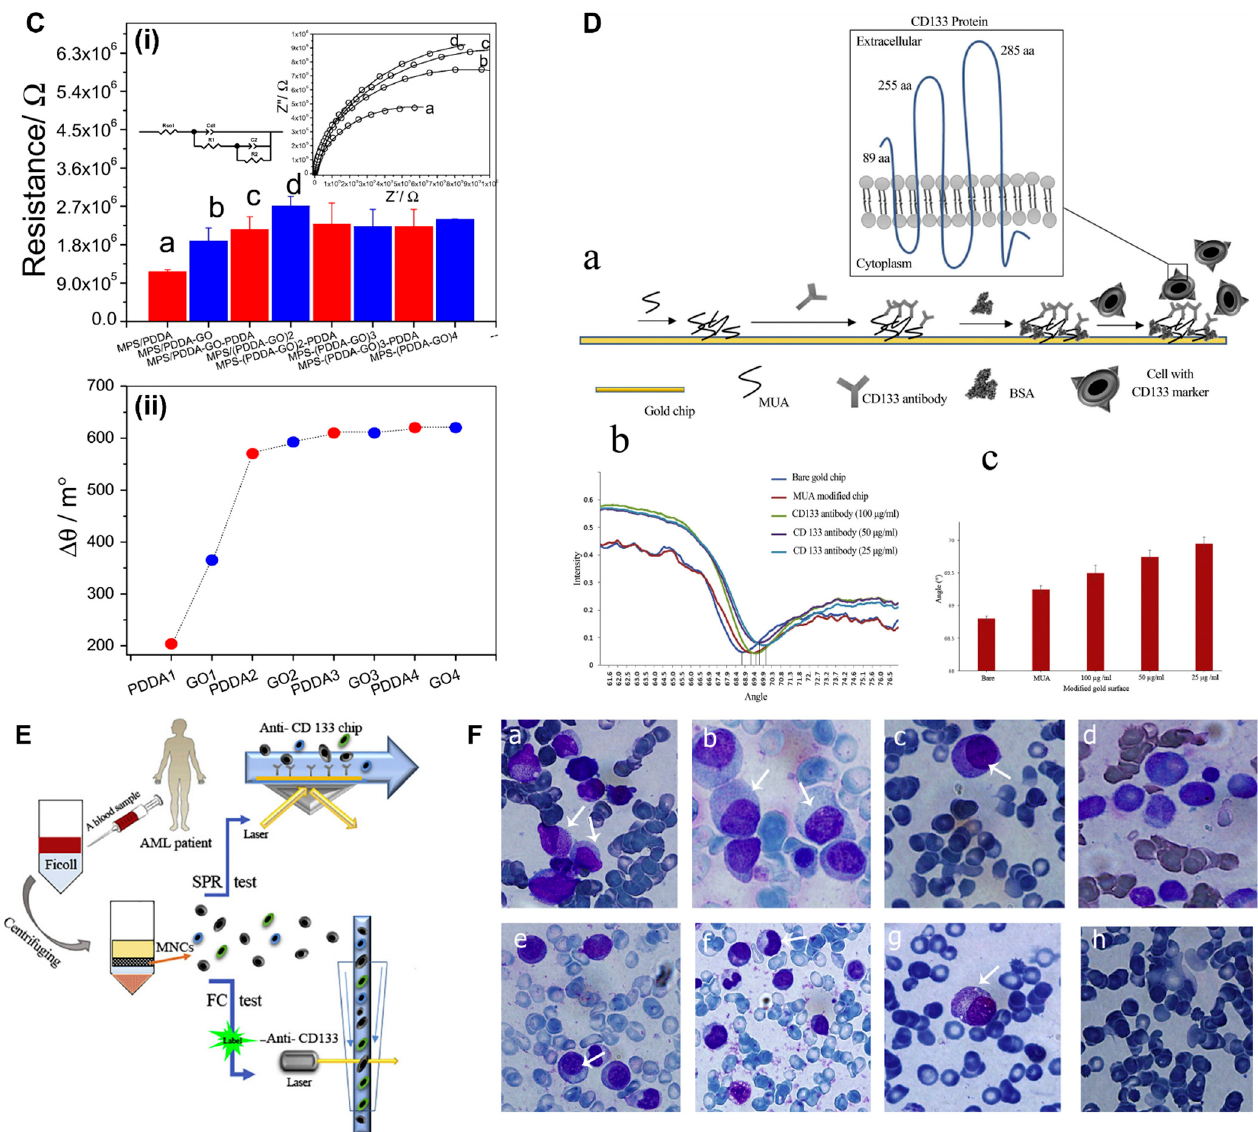
Figure 6. ( A , B ) Schematic depiction of several stages in the construction of the SPR miRNA-21 genosensor. Calculation of Δθ SPR from SPR sensogram acquired during developing miRNA-21 genosensor [124]. ( C ) i. For the Au/MPS system, bars show the fluctuation in overall Rct during the self-assembly of 1.00 mg mL − 1 PDDA (red) and 0.50 mg/mL GO (blue). ii. SPR determined from the sensorgram of 1.00 mg/mL PDDA (red) and 0.50 mg/mL GO (blue) sequentially. ( D ) a. A pictorial depiction of CD133 antibody attachment on a surface of gold; b. Sensorgrams acquired across several AML patients after injecting 1 × 10 5 cells onto surface pre-incubated with anti-CD133; c. Change in the SPR angle with bare sensor surface, after MUA modification, and after incubation with different concentration of CD-133 antibodies. ( E ) Schematic showing the experimental set up. ( F ) The microscopic examination slides to demonstrate the presence of myeloblastic progenitor cells in AML subjects [125]. The white arrow indicates cytoplasm/nucleus region of the cell. Slides a, b, d, e, g are AML cells taken from bone marrow, and slides c, f are AML cells taken from peripheral blood. Slide h is cells from peripheral blood of normal patient and progenitor cells were not